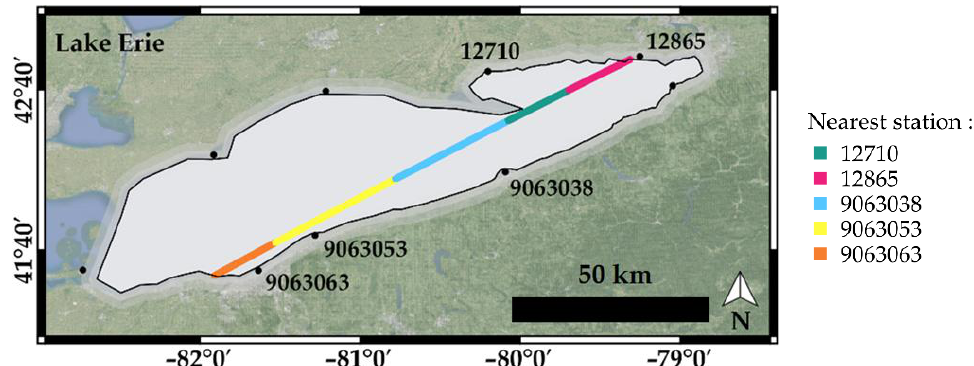
Figure 2. Example of the gauge stations over Lake Erie considered for the analysis of the accuracy of the GEDI track of the 31 October 2019 (beam 7).